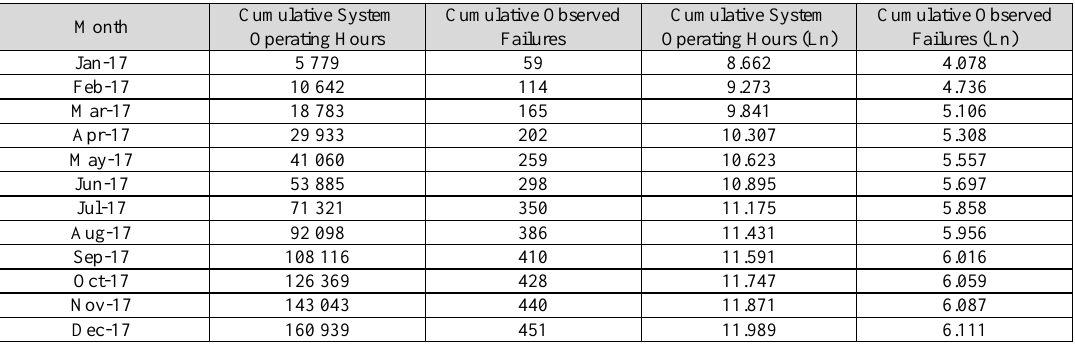
Table 2. Logarithms of cumulative system operating time and cumulative failures utilizing AMSAA model